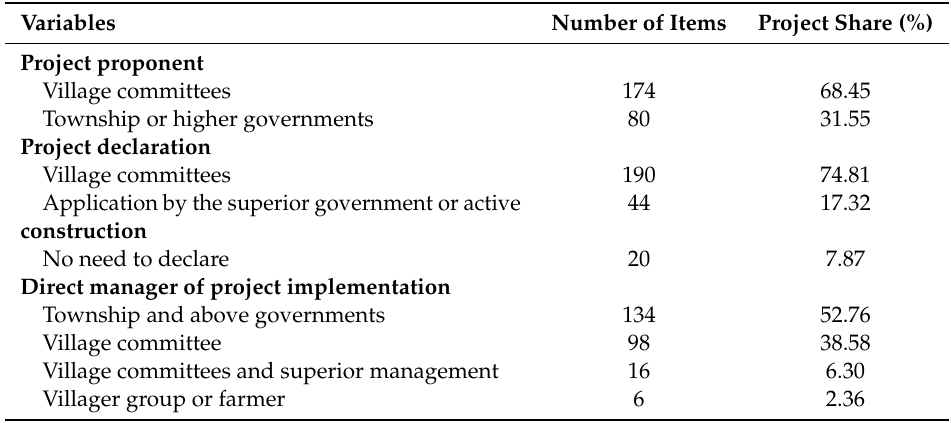
Table 2. Proposal, declaration, and management of agricultural infrastructure investment